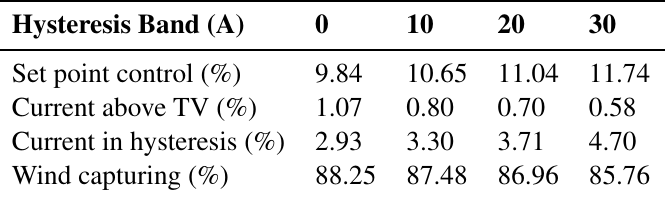
Table 6. Simulation results: full relief of the control action and the effect of the hysteresis band.